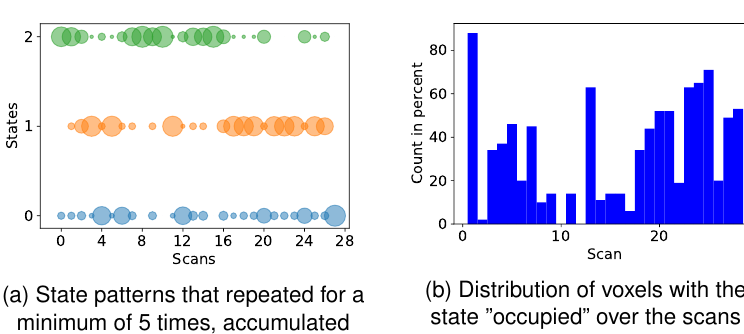
Figure 13. Pattern distribution for vegetation (a bush).